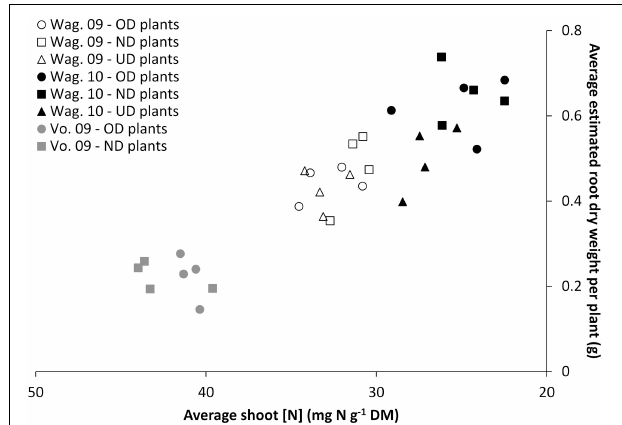
FIGURE 5 | Relationship between the nutritional status of the plant (average shoot [N]) and its estimated root weight for the two or three transplant sizes [Over-Developed- (“OD”), Normally Developed- (“ND”) and Under-Developed- (“UD”) transplant size], measured at the final harvest in the trials Wageningen 2009 (“Wag. 09”), Wageningen 2010 (“Wag. 10”) and Voorst 2009 (“Vo.